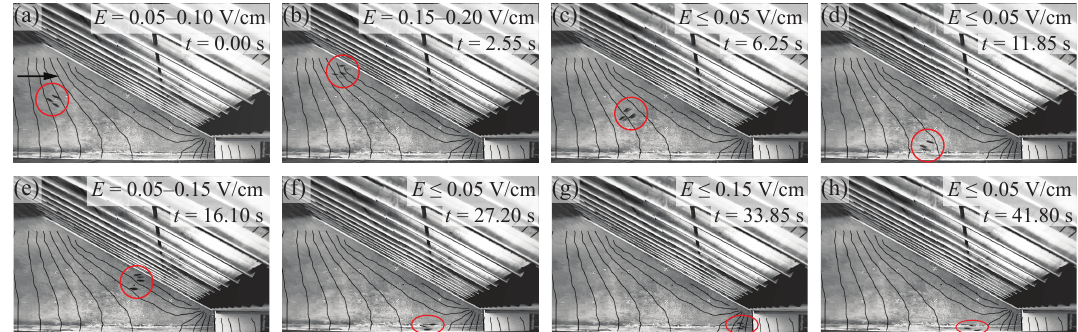
Figure 5. Typical behavior of spirlin ( Alburnoides bipuncatus ) at the e-HBR with s b = 51 mm and U e = 38 V, which were guided towards the bypass but refused to enter it; the spirlin are encircled in red and the equipotential lines are visualized in black. The approximate voltage gradient E at the current position of the fish group is given in the top right corner.